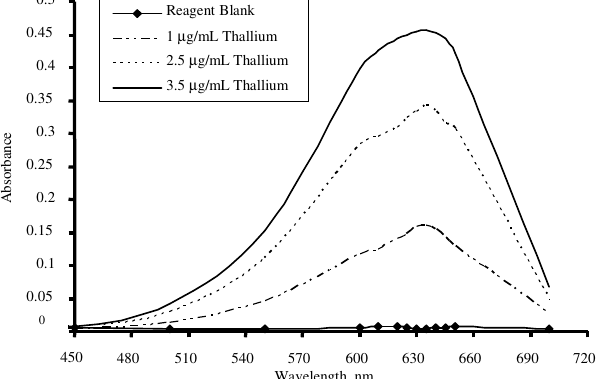
Figure 1. Absorption spectra of thallium(III) with MBTH &